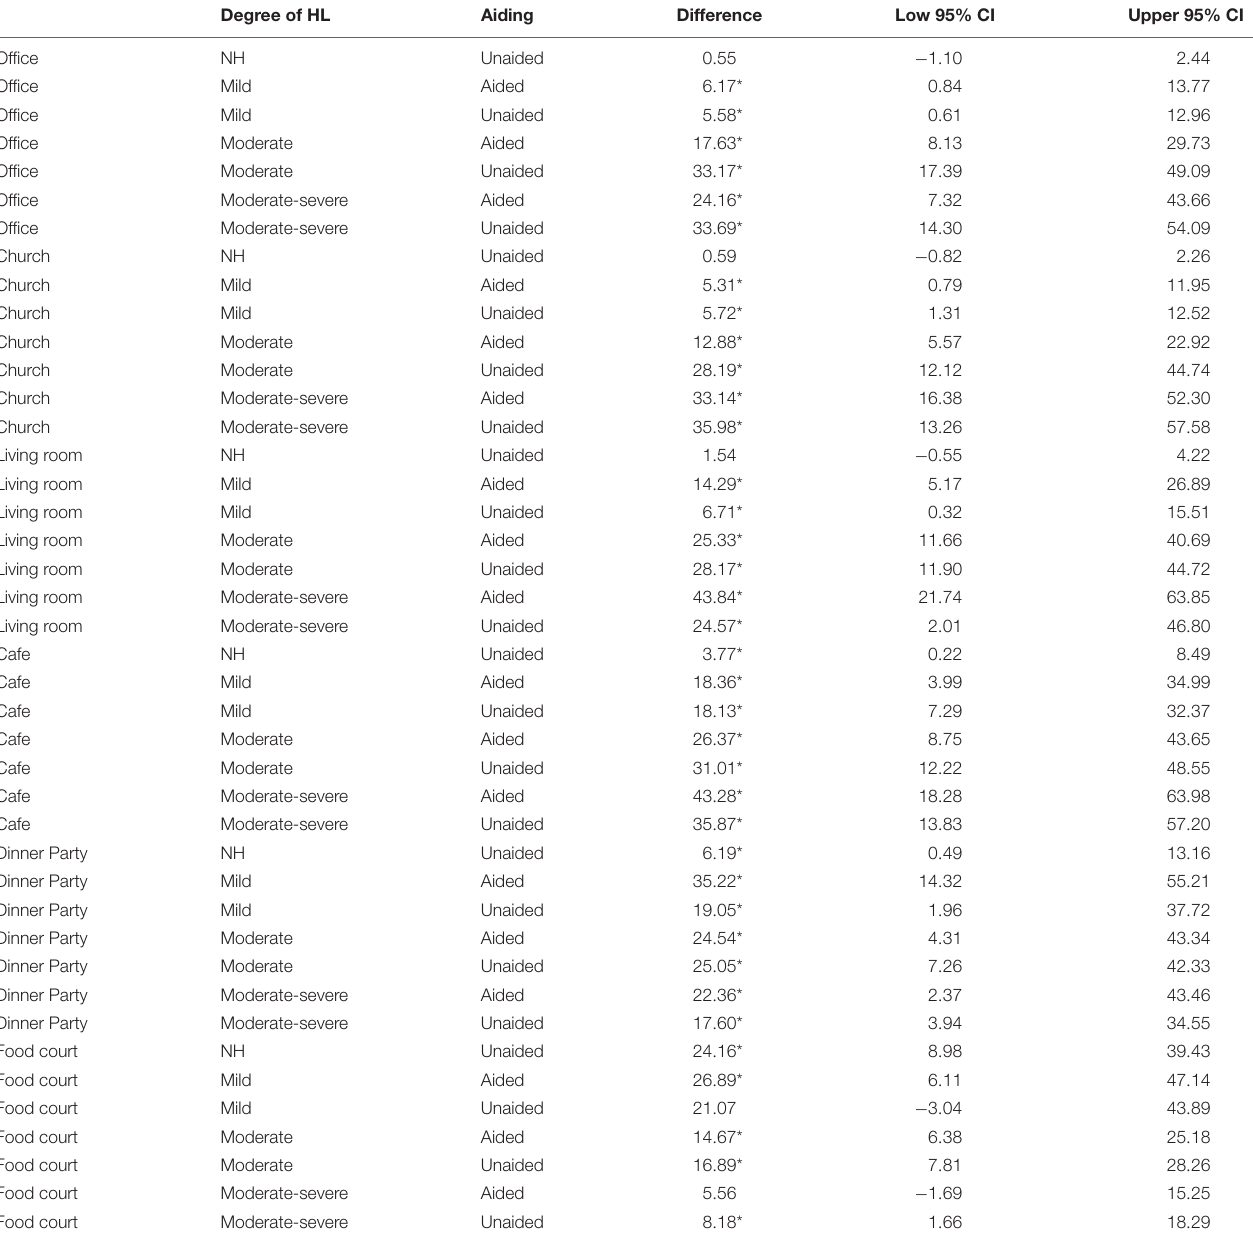
TABLE 3 | Results of the statistical analysis comparing intelligibility scores for the two types of speech materials. Degree of HL Aiding Difference Low 95% CI Upper 95%